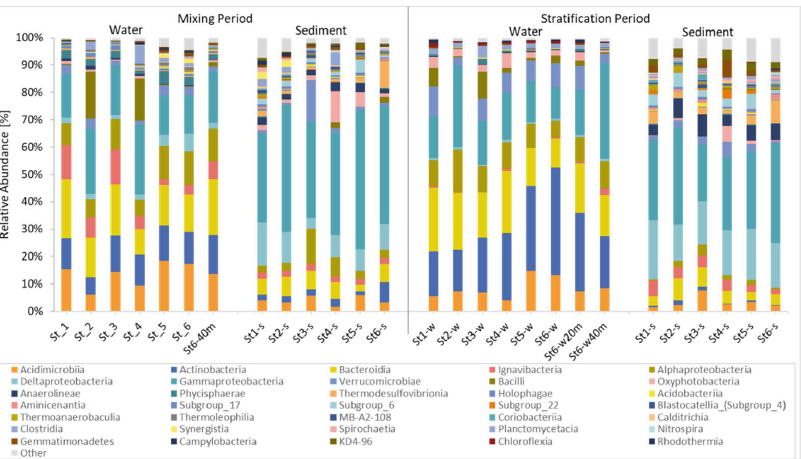
Figure 5. The relative abundances of the bacterial classes during the mixing and stratification period of the lake. The taxa with a relative abundance < 1% are merged and named as the other. During the stratification conditions, Actinobacteria and Verrucomicrobiae abun- dances went up in the water samples representing 15–39% and 3–11% of the total reads, respectively. Gammaproteobacteria and Alphaproteobacteria abundances were still high during this period. However, Ignavibacteria abundance decreased. In the sediment, alt- hough the bacterial community was dominated by Gammaproteobacteria, the abundance decreased compared to the mixing period. On the other hand, Deltaproteobacteria, Ther- modesulfovibrionia, Anaerolineae, and species were enriched in the sediment. The high- est abundance was recorded for site 6 both in the mixing and stratification conditions. At the family level, Ilumatobacteraceae, Sporichthyaceae, and Burkholderiaceae pre- dominated in the bacterial community of water in both periods (Supplementary Figures S1 and S2). However, their abundances varied due to the sampling period and location. The sediment community patterns in the sampling points showed high variation under mixing conditions; there was not a common family that dominated the community. While Competibacteraceae represented 18% of the total reads in site 2, the abundance was quite low in the other sites. Rubritaleaceae was only found in site 3, and 13% of the bacterial community was assigned to this family. While the community in site 4 was dominated by Xenococcaceae species (9%), Nitrosococcaceae was abundant in site 5 (13%). In the strati- fication period, Burkholderiaceae and Desulfobacteraceae were found as common fami- lies in the sediment. The summary of the alpha-diversity analysis is depicted in Table 2. In general, the water samples had lower Shannon and Faith’s PD values compared to the sediment, indi- cating less diverse communities. Moreover, the bacterial communities in sediments were more even. The highest richness and evenness were detected in the sediment sample col- lected from site 3 during the stratification period. On the other hand, the highest phylo- genetic diversity was found in the water sample collected from the same sampling point and time (site 3—stratification). Table 2. Summary of the alpha diversity of the bacterial communities in water and sediment sam- ples. Sampling Period